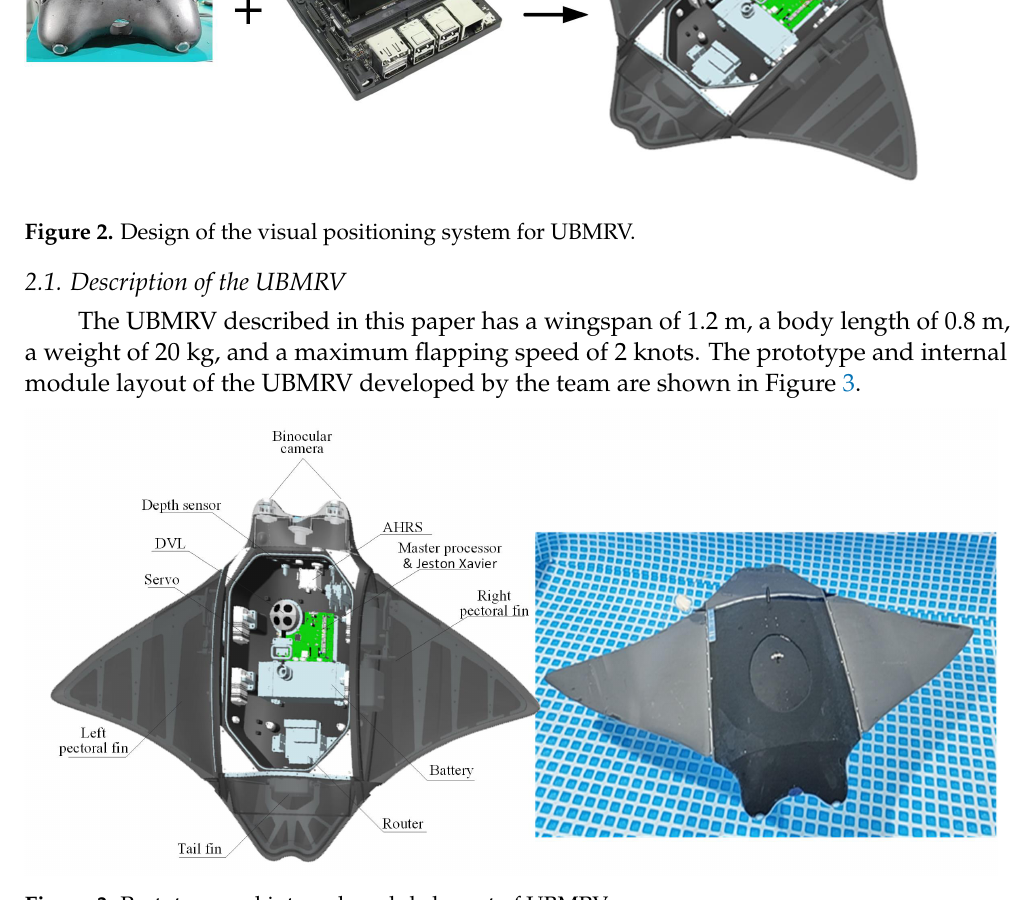
Figure 3. Prototype and internal module layout of